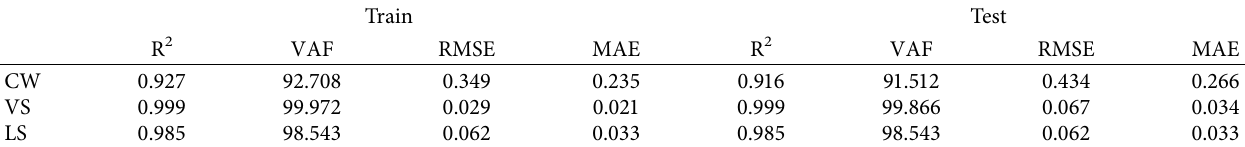
Table 6: Performance indicator values for building GWO models for outputs (CW, VS, and LS).